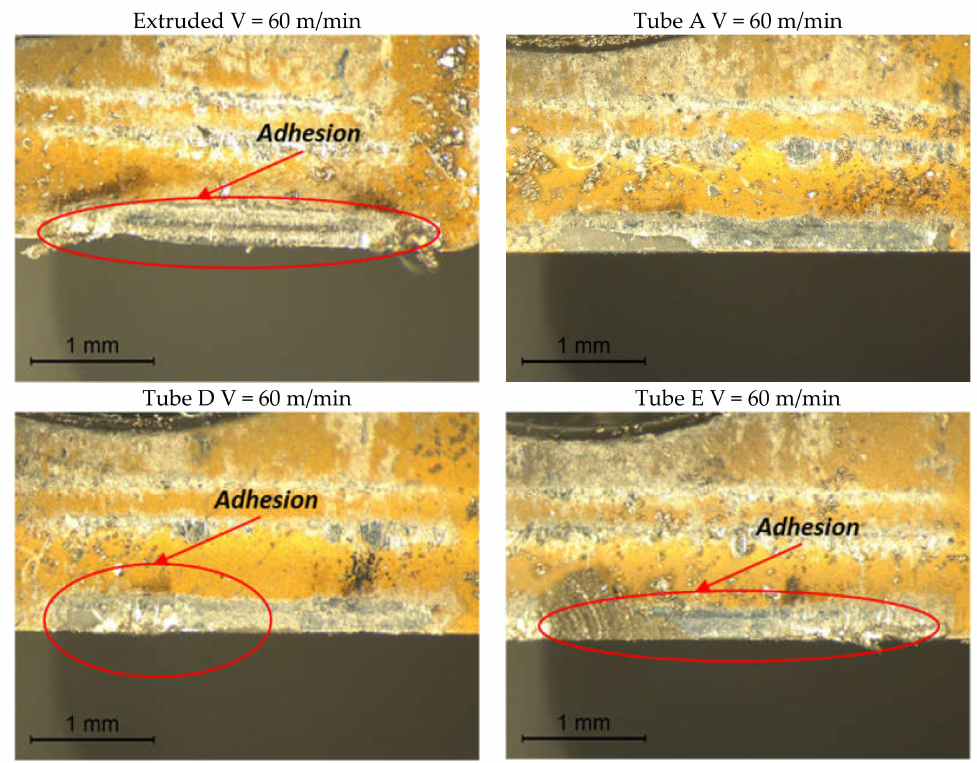
Figure 10. Rake face of the tool tip used for machining the extruded and the AM tubes with Vc at 60 m /